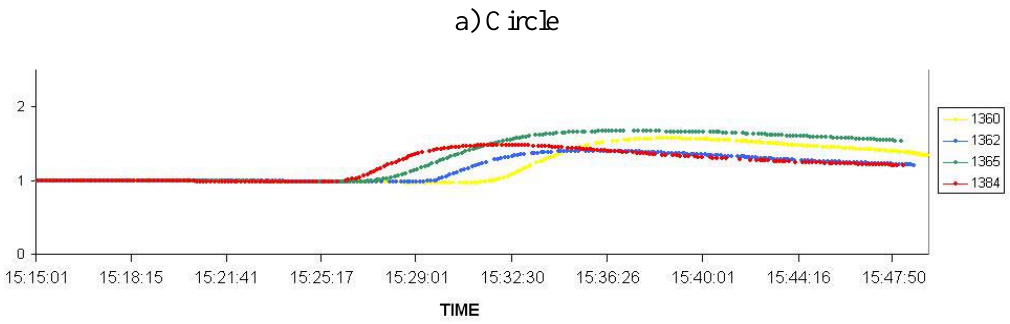
Figure 10. Temperature results of the eight MICA2 3 rd GEN